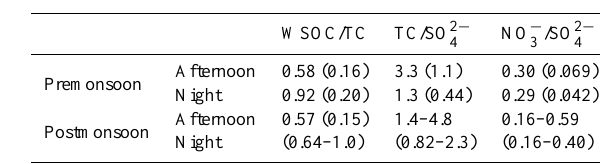
Table 3b. Mass ratios between chemical compounds in PM 1 . Av- erages and standard deviations (in parenthesis) are reported. For the sets including ≤ 4 samples, only the range of variation is given: